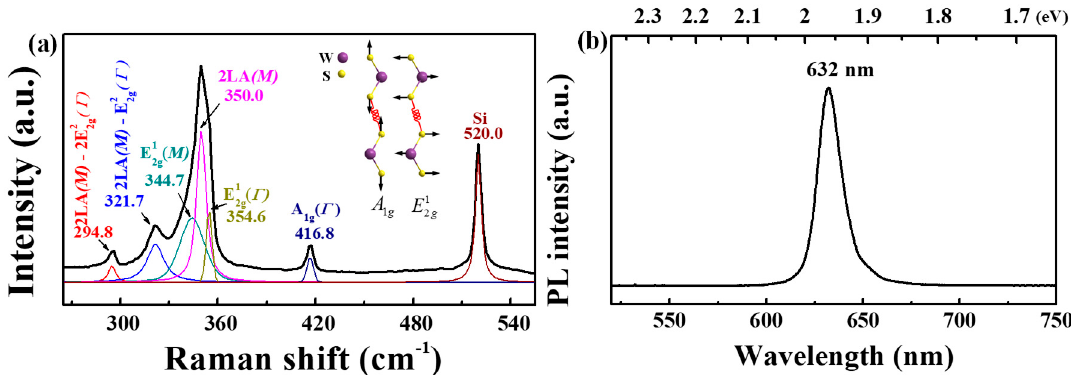
Figure 3. Room temperature Raman ( a ) and PL ( b ) spectra collected from an equilateral triangular WS 2 flake on SiO 2 /Si substrate with 532 nm excitation. The inset plotted in Figure 3a shows the schematic diagram of the atomic vibrations of A 1g ( Г ) and E 1 2 modes in WS 2 . It is noted that the black curve is raw data while the color ones are obtained by Lorentz fitting as shown in figure 3a.